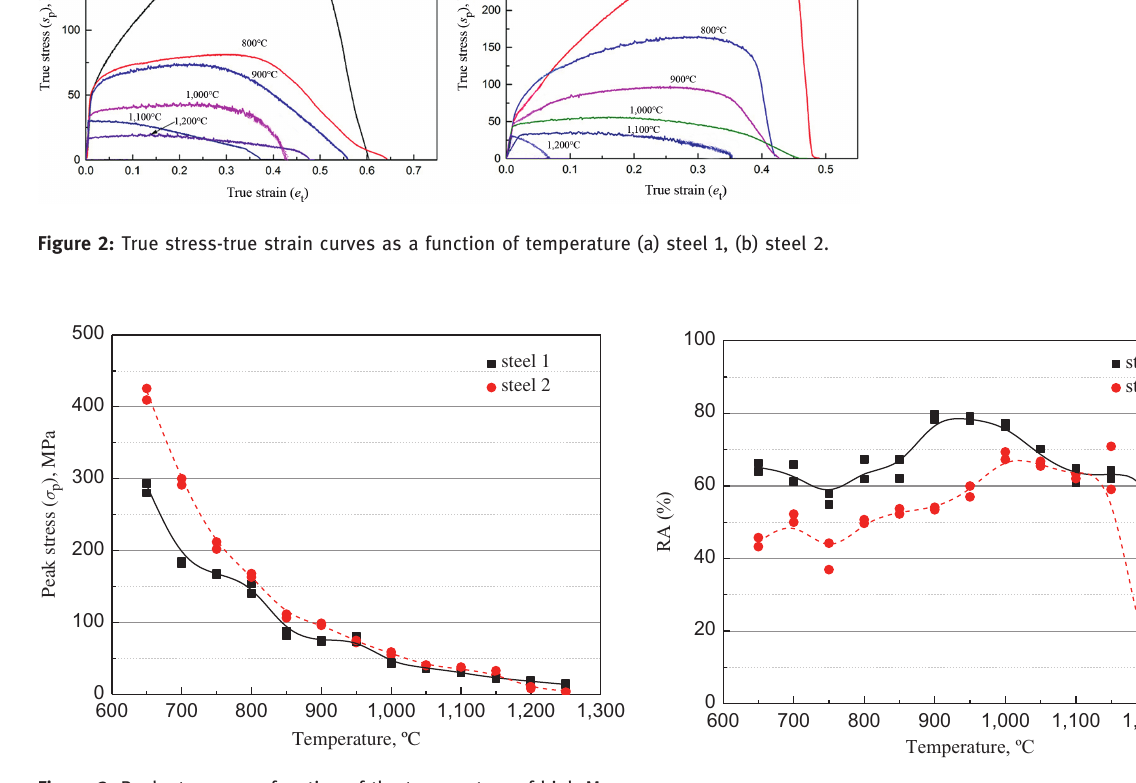
Figure 4: Hot ductility curves as a function of temperature of high- Mn austenitic